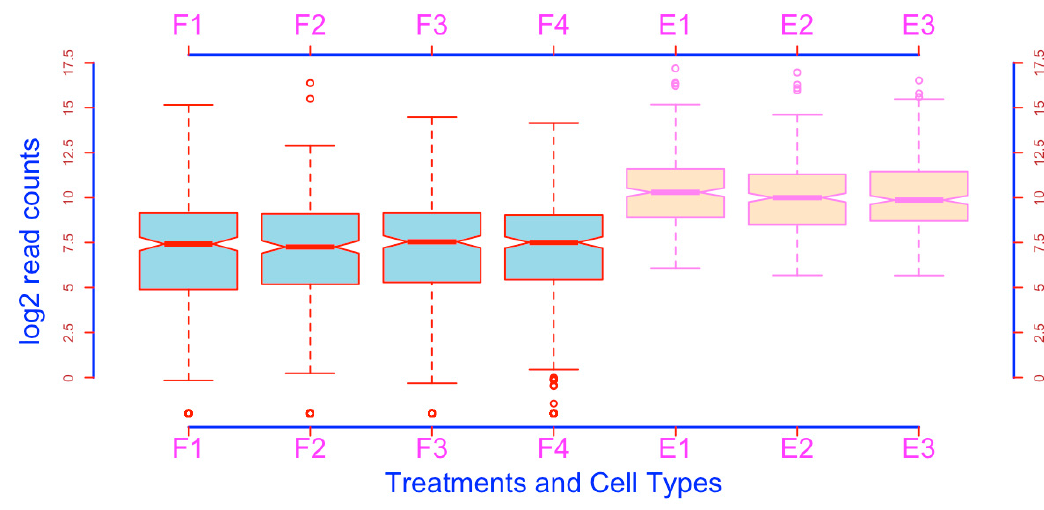
Figure 29. Add a y-axis to the right of boxplots.